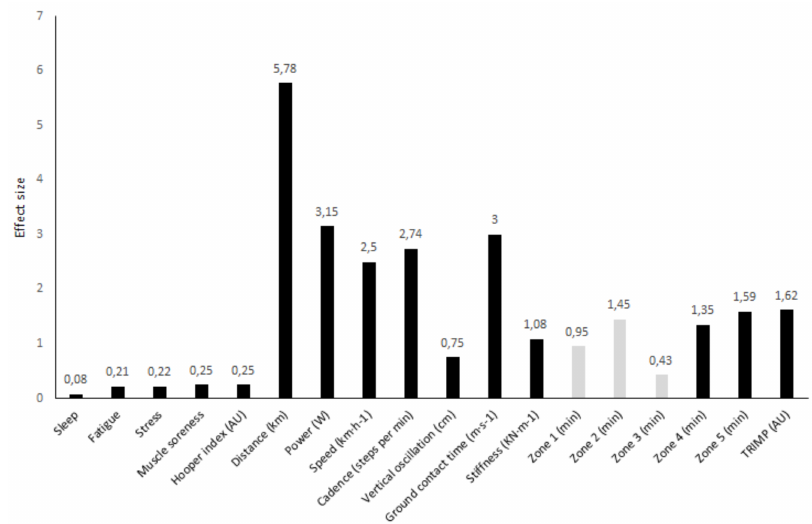
Figure 1. Effect sizes for the field referees’ (FR) and assistant referees’ (AR) differences in Hooper indices, external and internal match loads. Note. TRIMP = training impulse; black = higher values for FR; white = higher values for